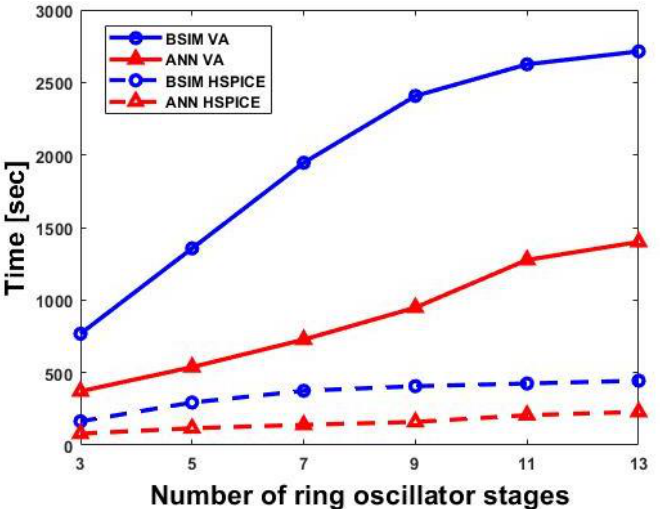
Figure 12. Time comparison of Monte Carlo simulations by stages of a ring oscillator using the global device